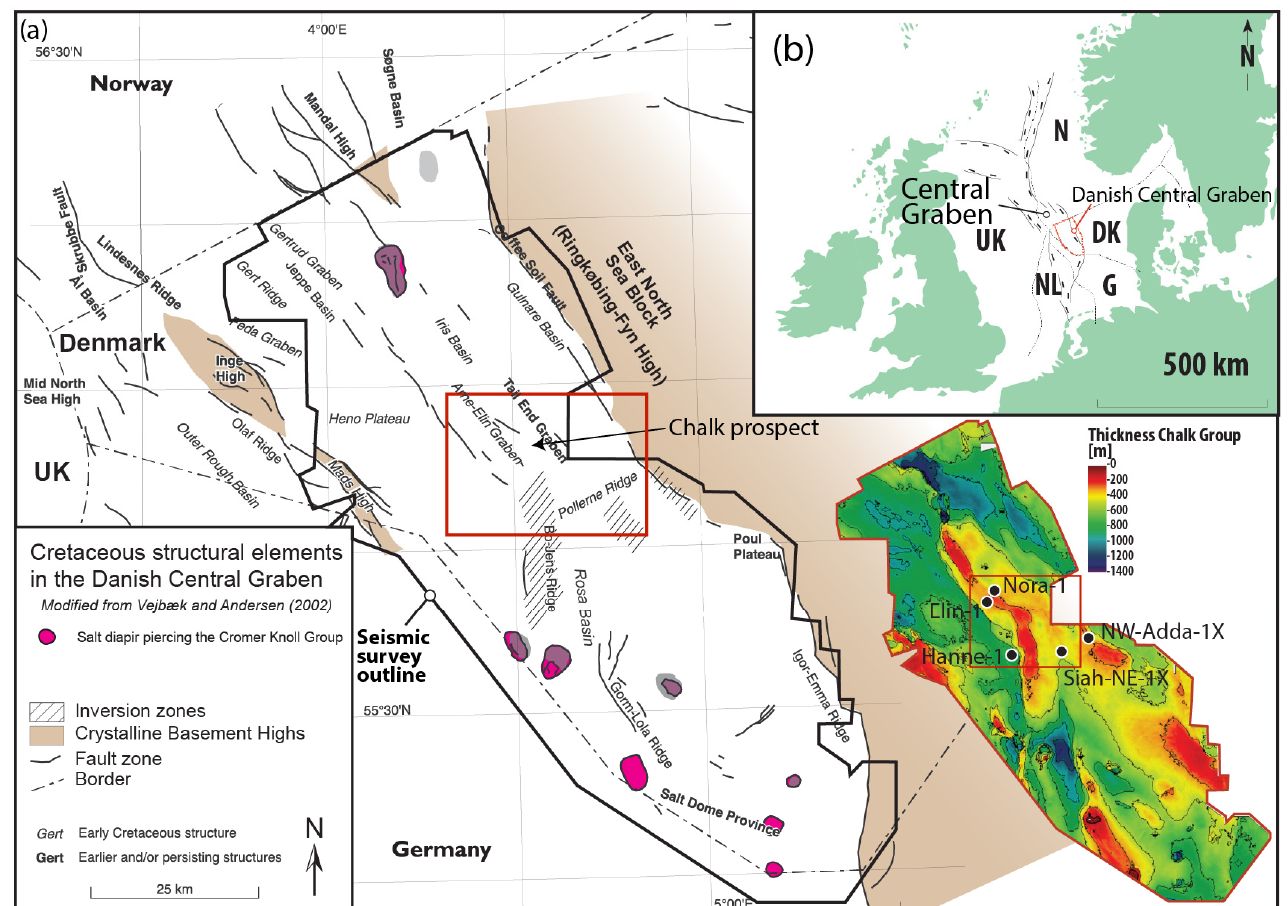
Figure 2. Map of the Danish Central Graben with the location of the different case studies. ( a ) Map with structure elements during the Cretaceous, adapted with permission from Reference [9] under Creative Commons Attribution 4.0 License. ( b ) Location of the study area within NW Europe.